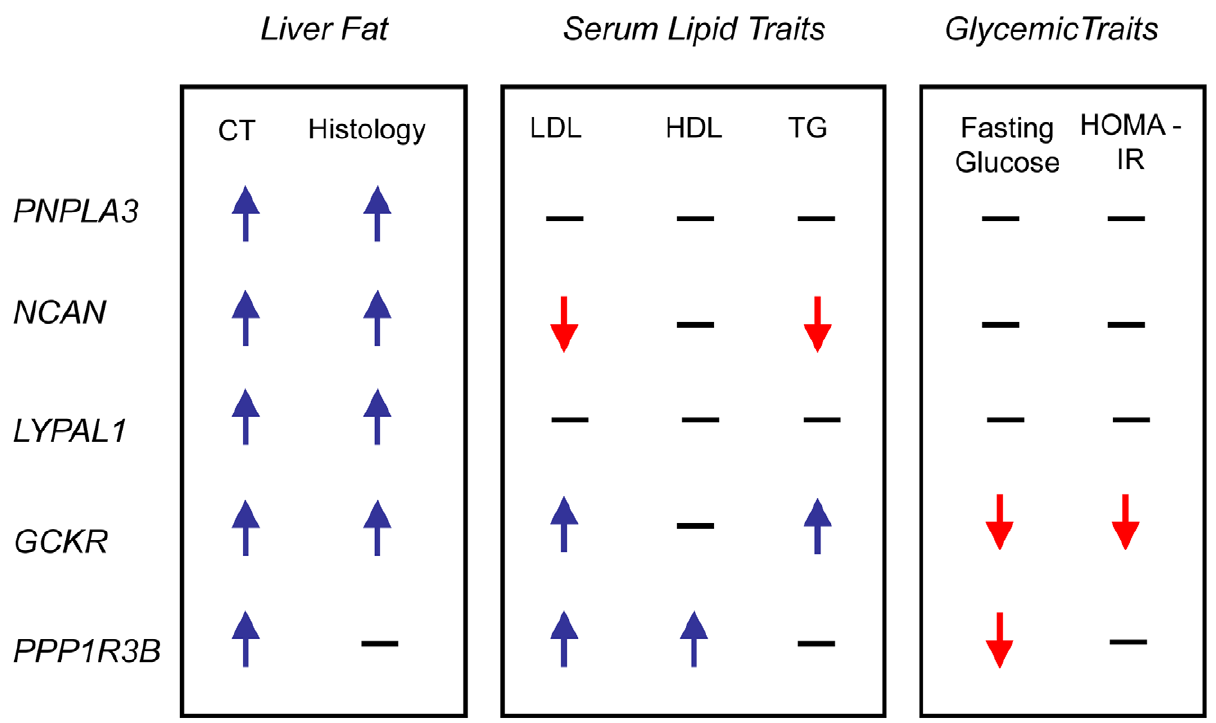
Figure 4. Effects on traits. Direction of effect on CT fatty liver, histology NAFLD, lipid and glycemic traits of the best associating SNPs at the loci shown. Direction is shown only for significant associations. CT: CT hepatic steatosis; LDL: low density lipoprotein cholesterol; HDL: high density lipoprotein cholesterol; TG: triglycerides; HOMA-IR: homeostatic model of insulin resistance; PNPLA3 : patatin-like phospholipase domain-containing protein 3 (HGNC: 18590); NCAN : neurocan (HGNC: 2465); LYPLAL1 : lysophospholipase-like 1 (HGNC: 20440); GCKR : glucokinase regulatory protein (HGNC: 4196); PPP1R3B : protein phosphatase 1, regulatory subunit 3b (HGNC: 14942).